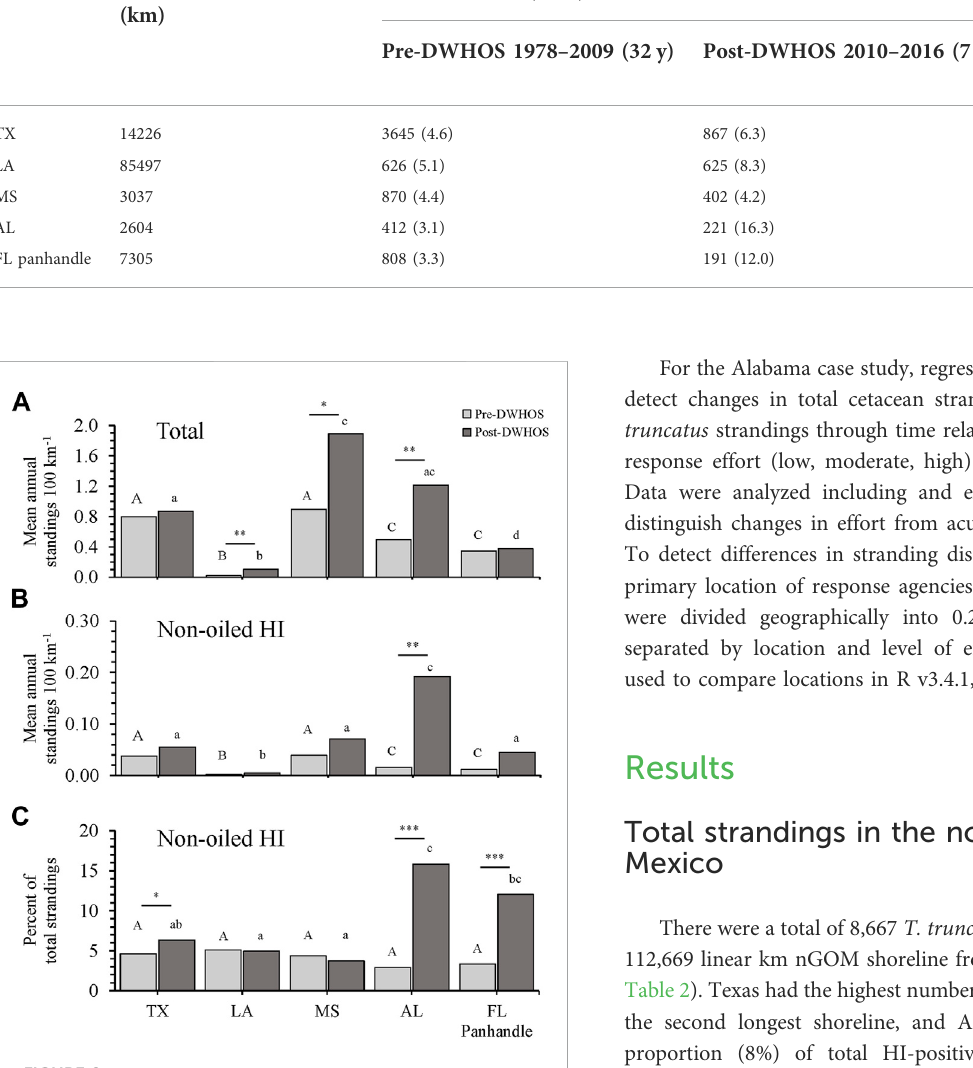
FIGURE 2 Total (A) and non-oiled HI-positive (B) mean annual strandings normalized to linear shoreline distance (100 km − 1 ) and non-oiledHI-positivecasesasapercentageoftotalstrandings (C) , separated by state and pre- (1978 – 2009) and post- (2010 – 2016) DWHOS coverage periods. Capital and lower-case letters indicate signi fi cant differences among locations for pre- DWHOS and post-DWHOS coverage periods, respectively. Asterisks indicate differences between coverage periods within each state, where * p < 0.05, ** p < 0.01, *** p <